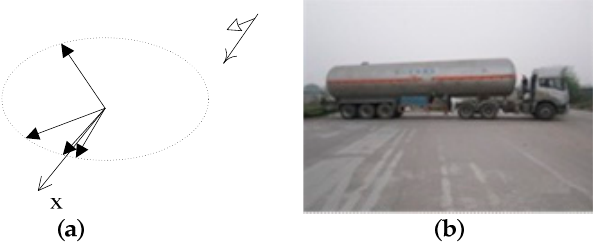
Figure 4. Four tank trucks parked at predetermined aspect angles in Experiment IV. ( a ) The geometric relationship between SAR and tank trucks; and ( b ) a tank truck with a cylindrical shape.